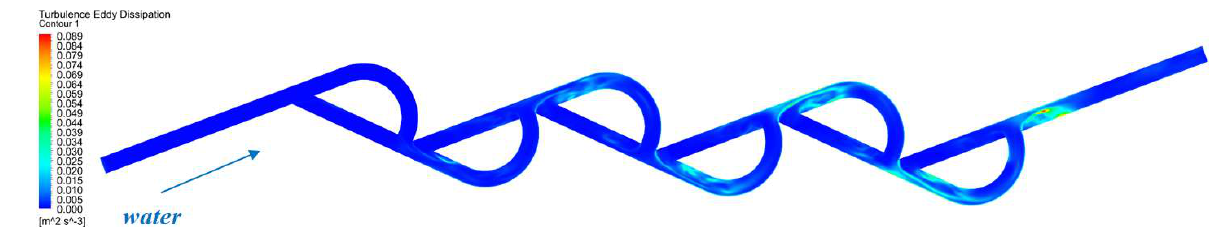
Figure 12. Cloud diagram of turbulent kinetic energy distribution .